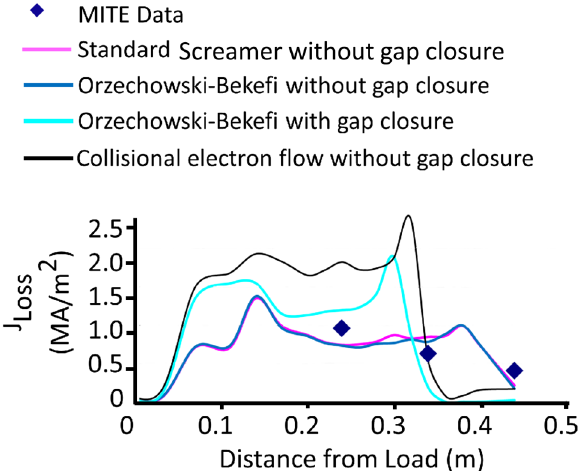
FIG. 8. Comparison of the computed time-integrated current density and the values measured on the sides of the MITE tapered convolute for four variations of the Screamer MITL model with Z Loss